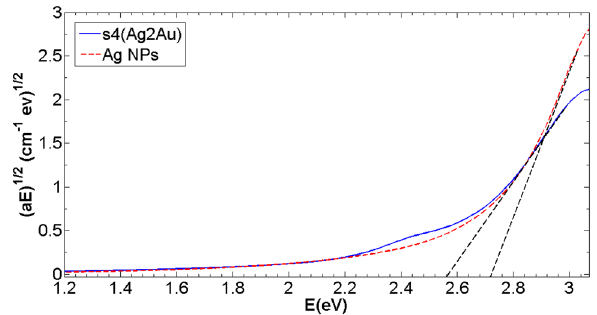
Fig. 5 Tauc plots to extract the bandgap energy of Ag line) and Ag NPs (dashed red line) as a